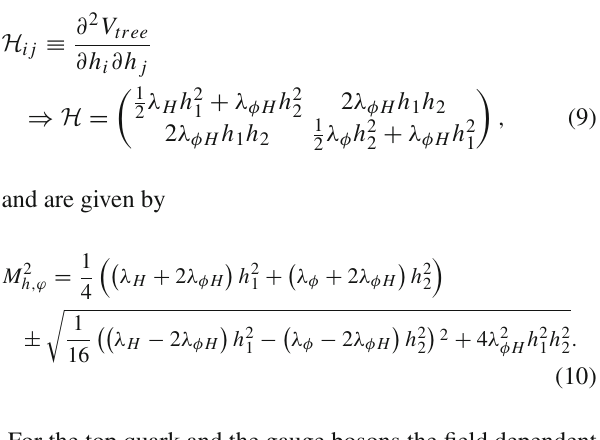
Fig. 2 Field-dependent masses of scalars. M 2 white region, M 2 ϕ will be